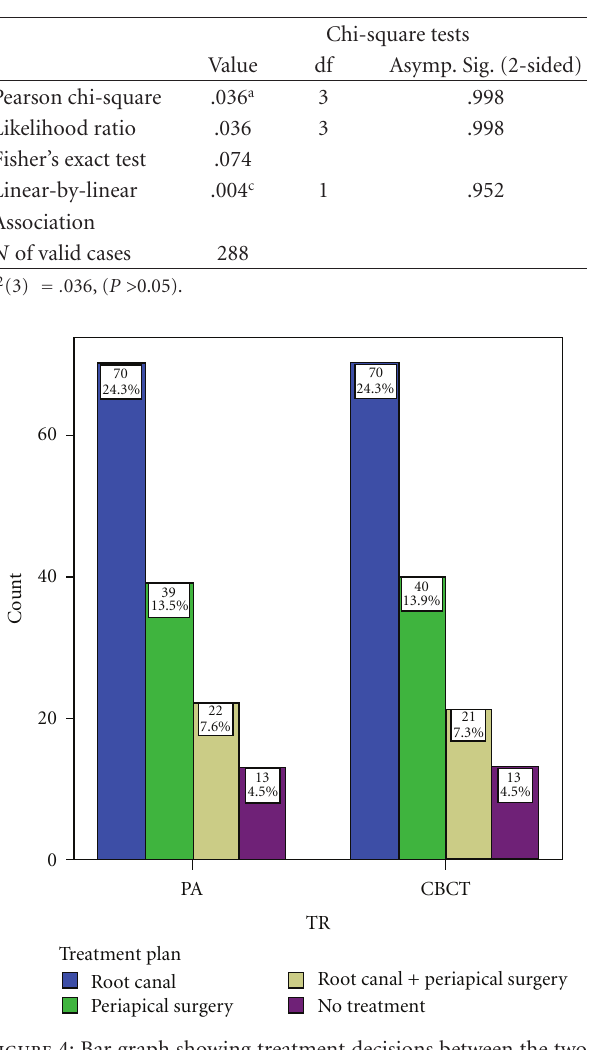
Figure 4: Bar graph showing treatment decisions between the two modalities (PA and CBCT).